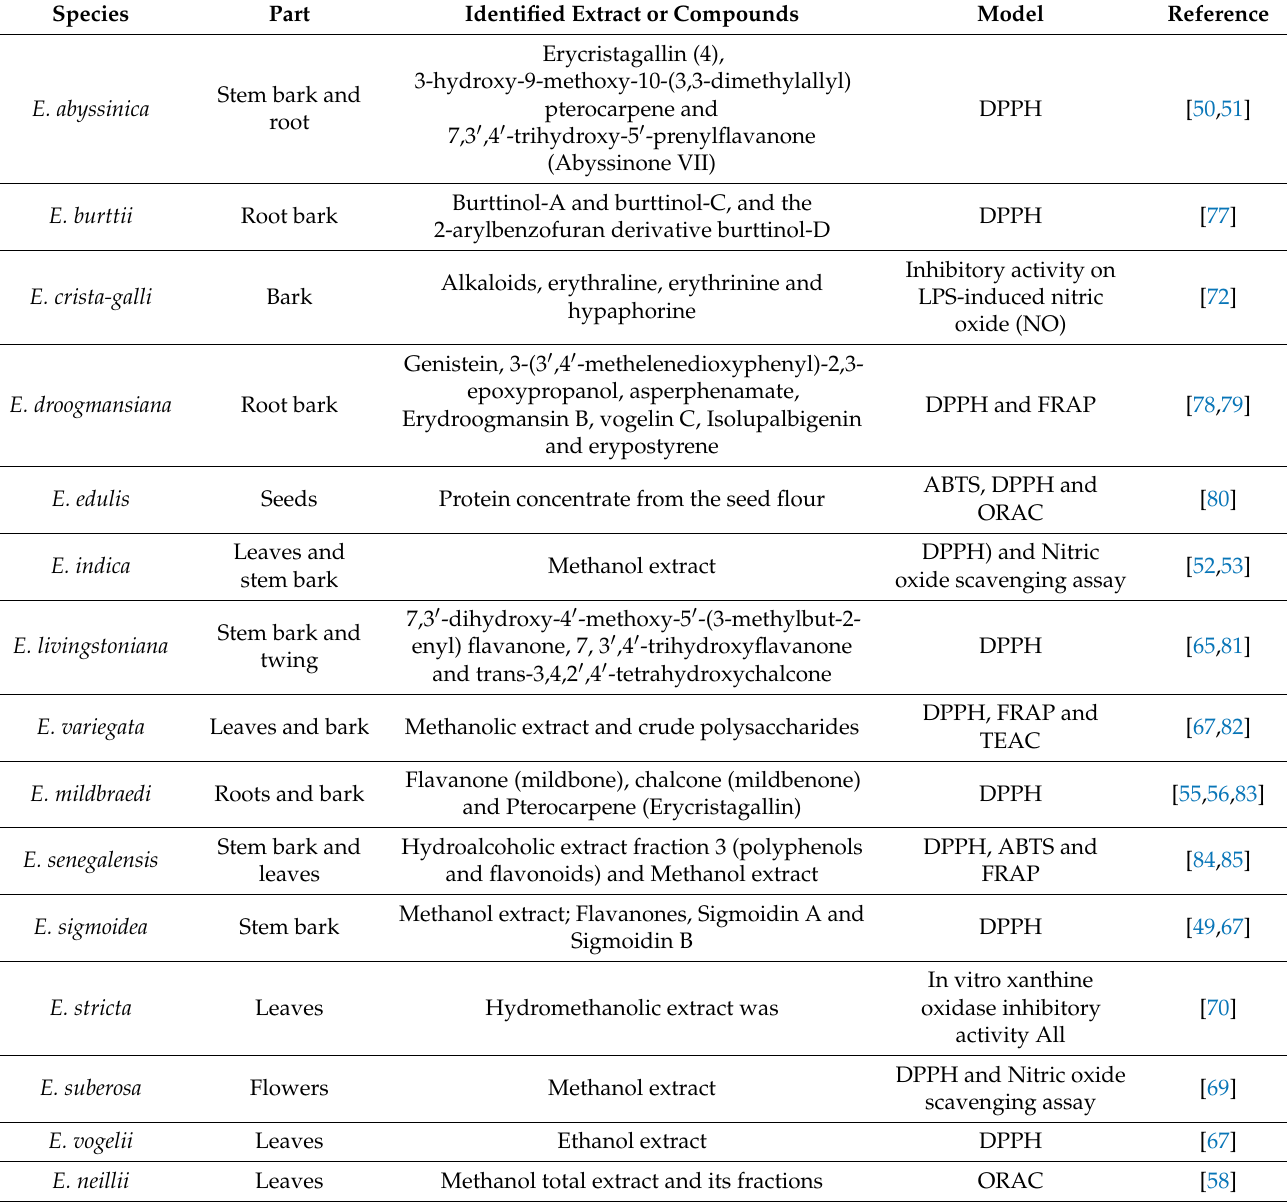
Table 3. Antioxidant activity of species from genus